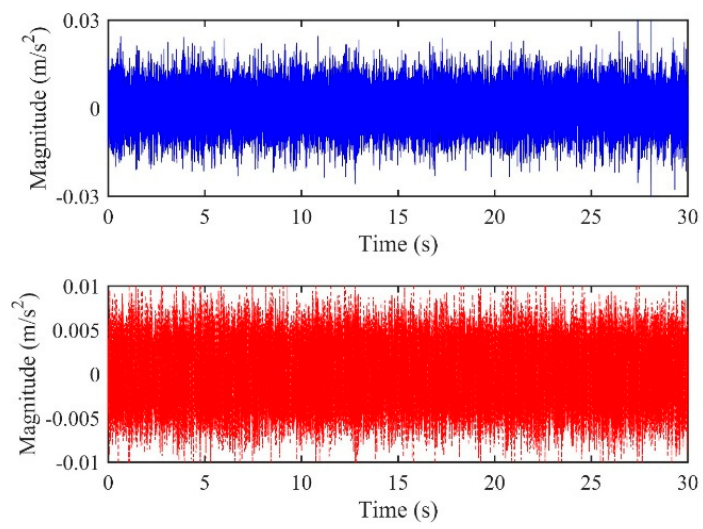
Figure 20. The proposed ADPHAT algorithm for TDE when D = 78.8 m.